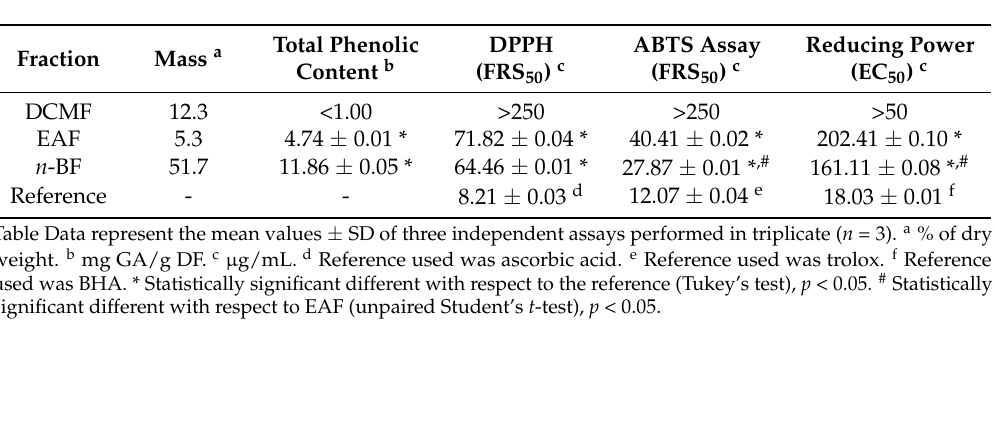
Table 1. Extraction yields and antioxidant capacity of S. stellata ethanolic extract fractions.